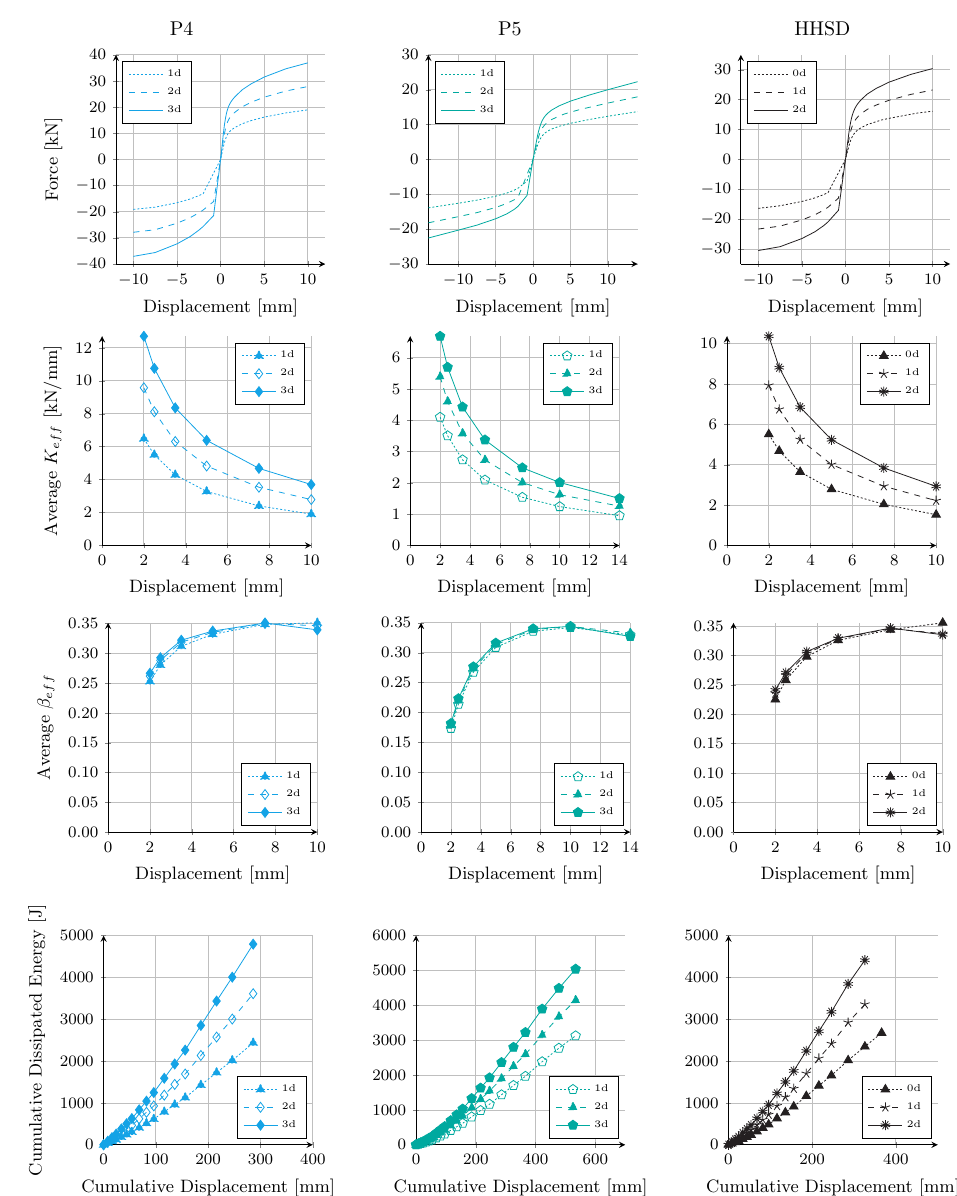
Figure 14. Influence of number of diagonals on the behavior of dampers P4, P5 and HHSD. 0d, 1d, 2d and 3d represent the number of diagonals in the plate. The behavior of the original design is represented by triangular